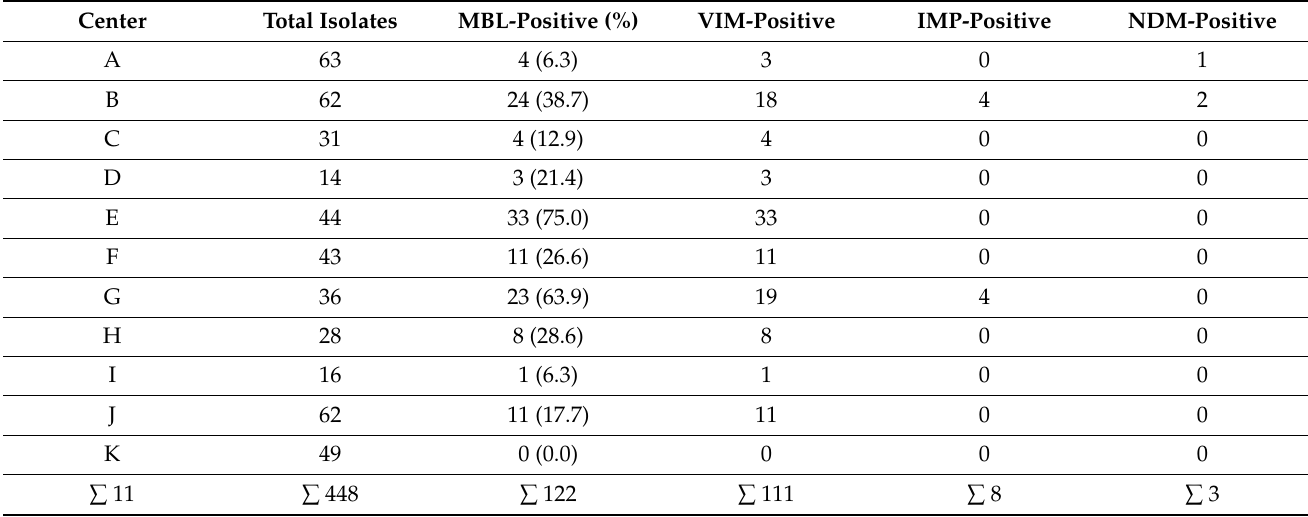
Table 1. Proportion of metallo- β -lactamase (MBL)-positive isolates to total number of meropenem- resistant isolates by center.